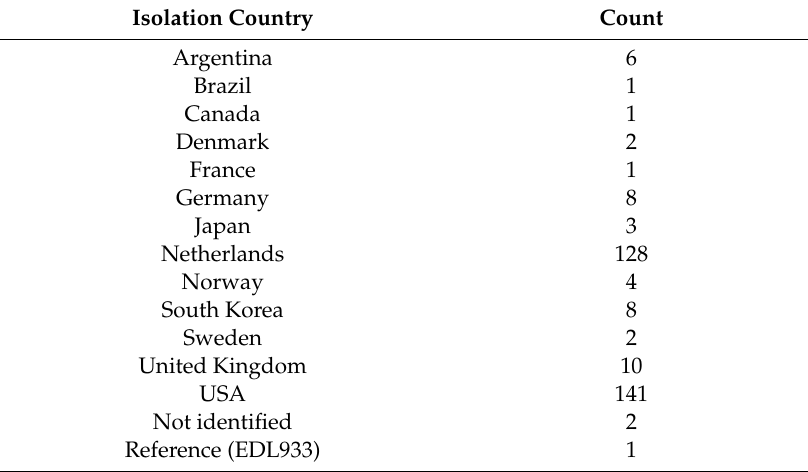
Table 1. Enterohemorrhagic Escherichia coli (EHEC) strains used for this study. Isolation Country Count Argentina